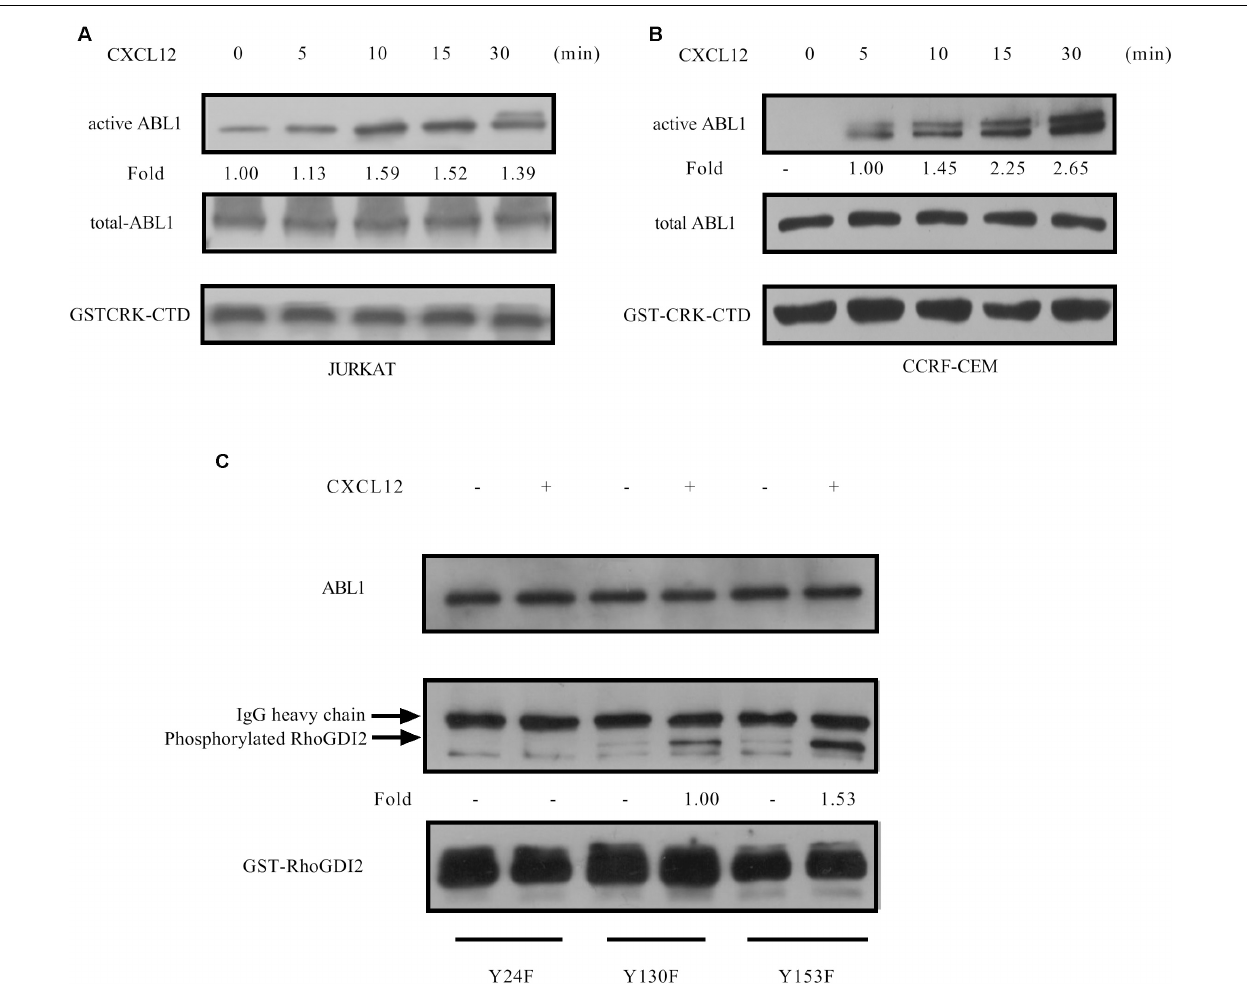
FIGURE 7 | CXCL12 can activate ABL1 in T-ALL cells. (A,B) Starved JURKAT or CCRF-CEM cells were incubated with CXCL12, and then cell lysates were prepared: 500 µ g of cell lysates were incubated with GST-Crk-CTD in the GST pull-down assay, followed by Western blot assay, using the antibody to ABL1. Western blot bands were analyzed using Image Pro Plus 6.0, and fold changes of active ABL1 were normalized according to GST-CRK-CTD. Total ABL1 was used as another loading control. (C) Next, 2 µ g of GST-RhoGDI2-Y24F, GST-RhoGDI2 Y130F, or GST-RhoGDI2 Y153F were introduced and incubated with active ABL1 immunoprecipitated from CCRF-CEM cells treated with CXCL12 at 37 ◦ C for 30 min in the in vitro kinase buffer for 30 min. Samples were boiled in 1 × Loading buffer at 98 ◦ C for 5 min and then resolved by SDS-PAGE. PY20, ABL1, or GST antibody was used in the Western blot assay to detect the phosphorylation of RhoGDI2, the amount of active ABL1, or RhoGDI2 (WT or mutated) that we used in each in vitro kinase assay, respectively. Phosphorylated RhoGDI2 were normalized according to the mutants of GST-RhoGDI2. ABL1 was used as another loading